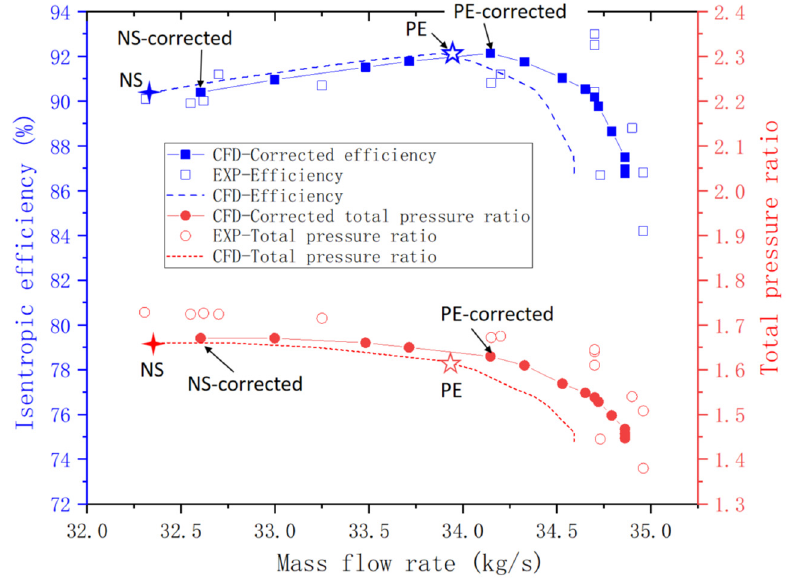
Figure 9. Compressor characteristics validated with experimental data.